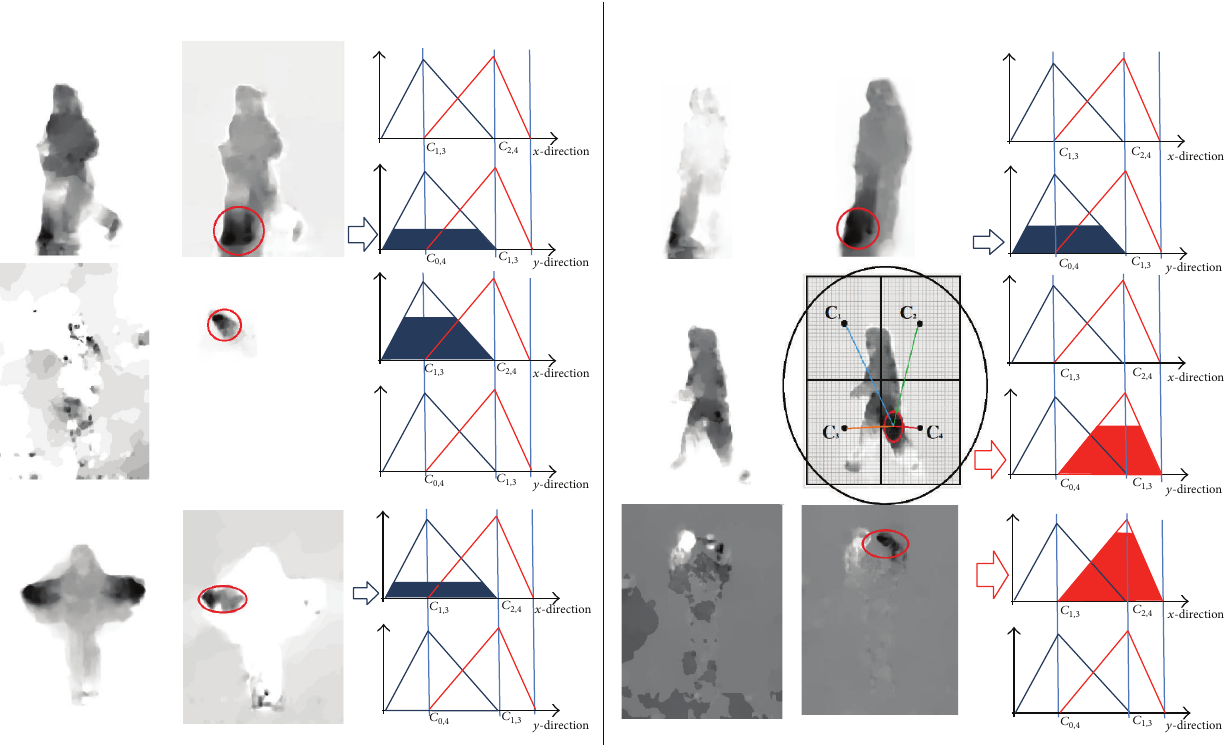
Figure 3: The results of dorsal processing stream obtains through optical flow [25] along with division procedures have been depicted. The resolution of divisions is designed for categorization of actions group to have additional interfere of dorsal and ventral processing streams. It can be a good representative of the interaction on MT, middle temporal of dorsal stream, and V4, ventral stream (for shape and orientation), or the MST area with inferior temporal (IT) (see more details in [32, 33]). The membership function of the action will be estimated from the position of maximum flow in the flow image. Membership values are aggregated through the proposed technique to increase the robustness. The input image of action mentioned in the figures is obtained from KTH human action recognition dataset